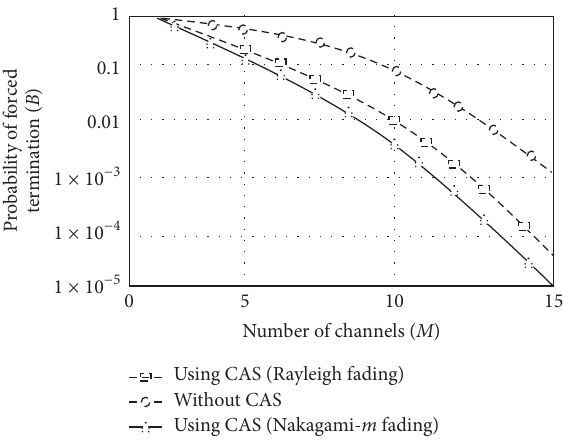
Figure 4: Variation of probability of forced termination against the number of